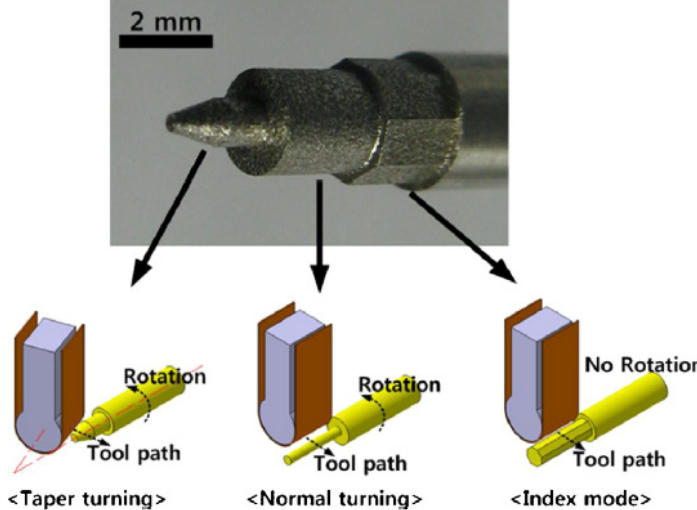
Figure 7. An axial-symmetric shape fabricated by Strip-TET process (Reprinted/Adapted with permission from [30]. 2013, Elsevier. ©).